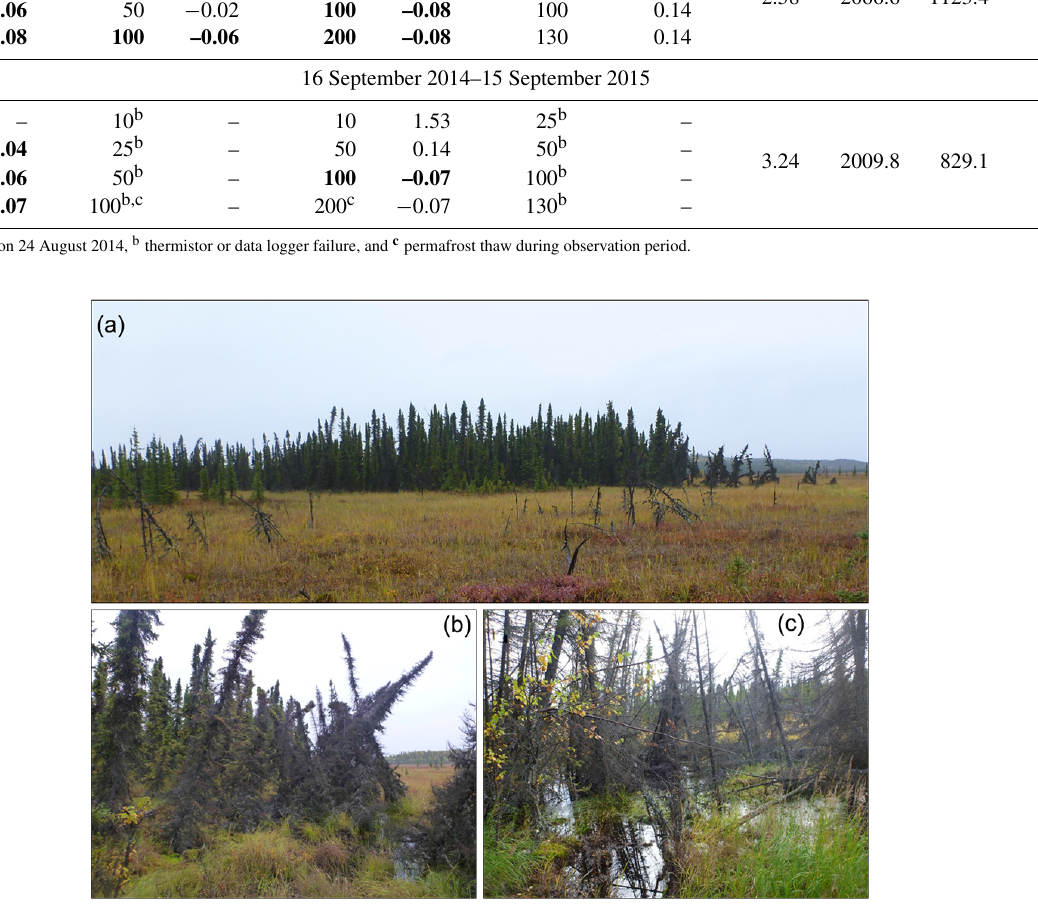
Figure 3. Field photos of residual permafrost plateau landforms and thermokarst in the western Kenai Peninsula lowlands. (a) A forested permafrost plateau in the Browns Lake wetland complex. A thermokarst moat and drowning black spruce trees in the (b) Browns Lake and (c) Watson Lake wetland